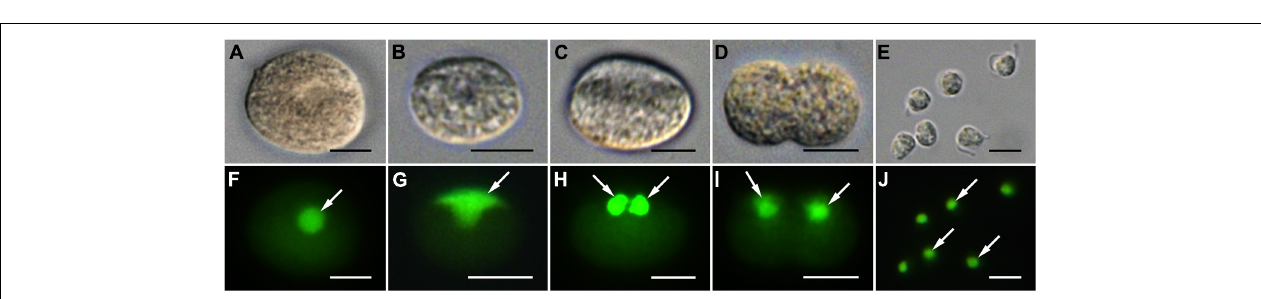
FIGURE 2 | Scanning electron microscopy (SEM) images showing the late trophocyte and sporocyte during sporogenesis stages of Pararosarium dinoexitiosum . (A) Late trophocyte with smooth surface of the wall. (B,C) Mature trophocyte (asterisk) emerging from the trophocyte wall (arrow). (D) Complete emergence of mature trophocyte showing rounded body and smooth surface. (E) The initial stage of sporocyte division showing a long transversal groove (arrow) on the central surface of one side. (F) The middle stage of the sporocyte division showing an invagination (arrowhead) in the direction perpendicular to transversal groove (arrow). (G) Two completely divided sporocytes. (H) Three linked sporocytes. (I–L) Sporocyte before the last division stage showing a gradual change into an elongated body shape and development of the flagella (arrowheads) from the transversal groove (arrow) of the body. (M) Fully developed flagella of a sporocyte. (N,O) Last division of the sporocyte showing rounded immature zoospores with flagella. (P) Immature zoospores that are gradually changing into the sigmoid shape. Scale bars: (A–C) = 10 µ m, (D–H) = 5 µ m, (I–P) = 2 µ m.